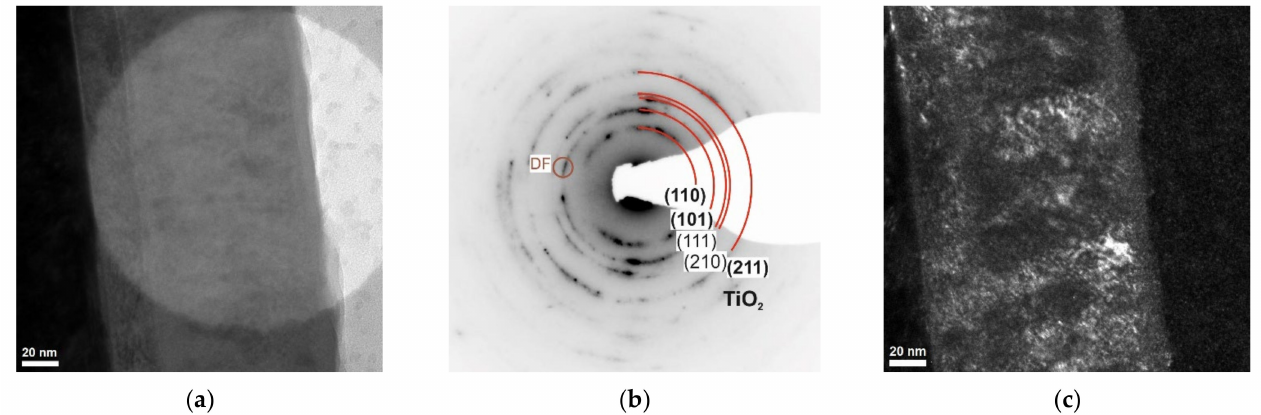
Figure 4. Structure (TEM) of TiO 2 /TiO 2 bimodal coating obtained: ( a ) bright-field—an area of diffraction analysis, ( b ) diffraction pattern, and ( c ) dark field from reflections corresponding to the planes (101) for the TiO 2